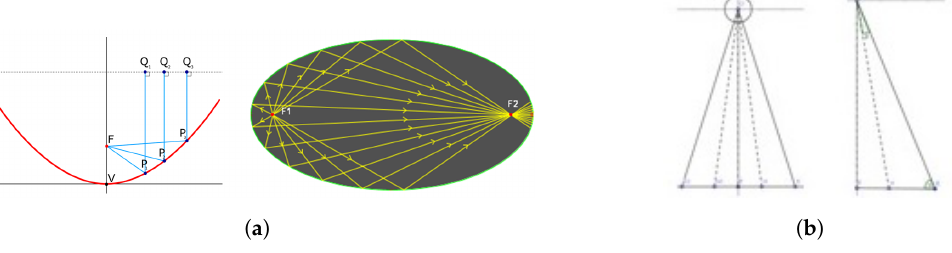
Figure 2. ( a ) The reflecting characteristics of a parabola and an ellipse are visualised [9,10]; and ( b ) geometrical representation to calculate the amount of rays not being reflected by the